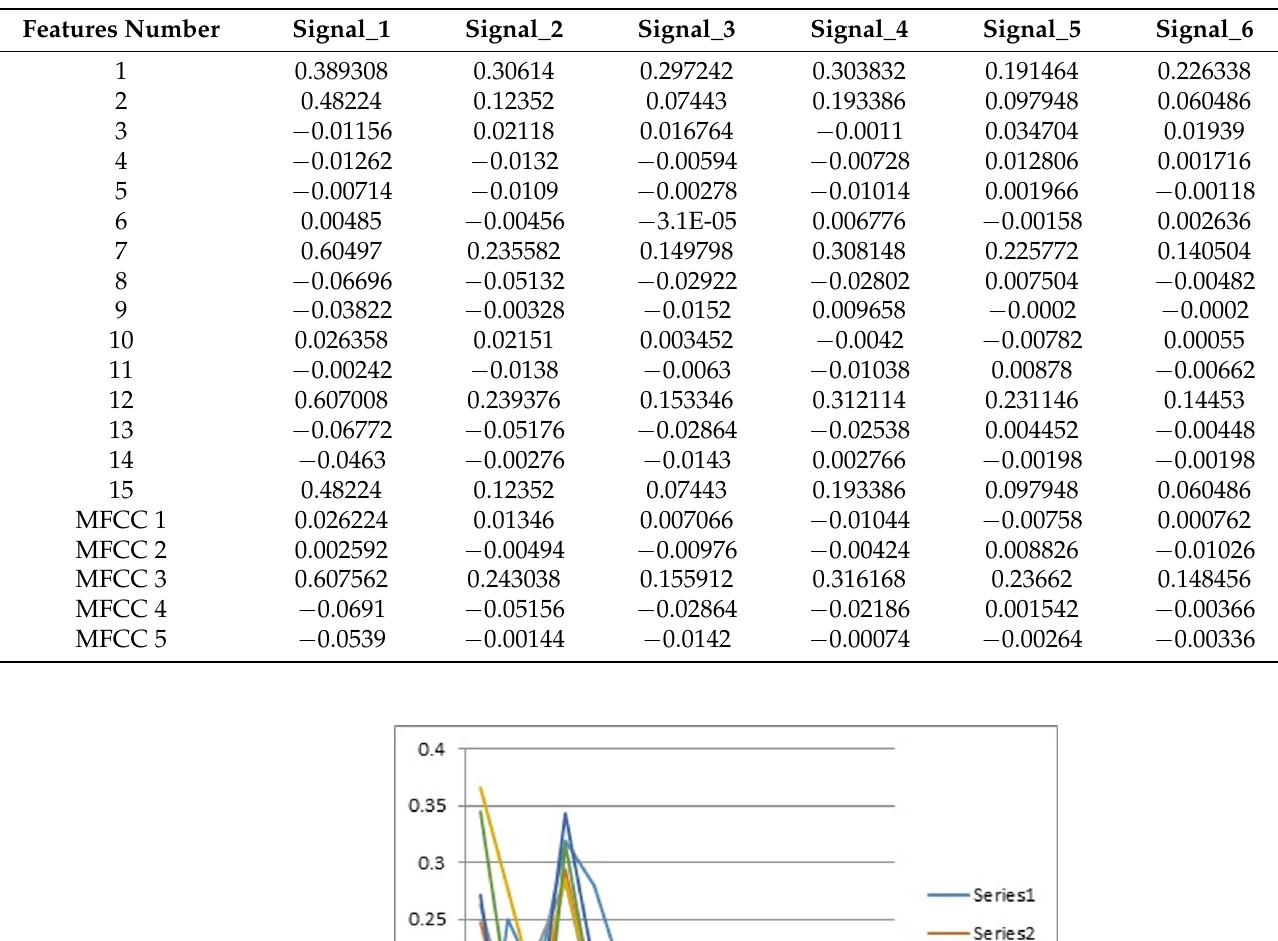
Table 2. Numeric values of the collected features.